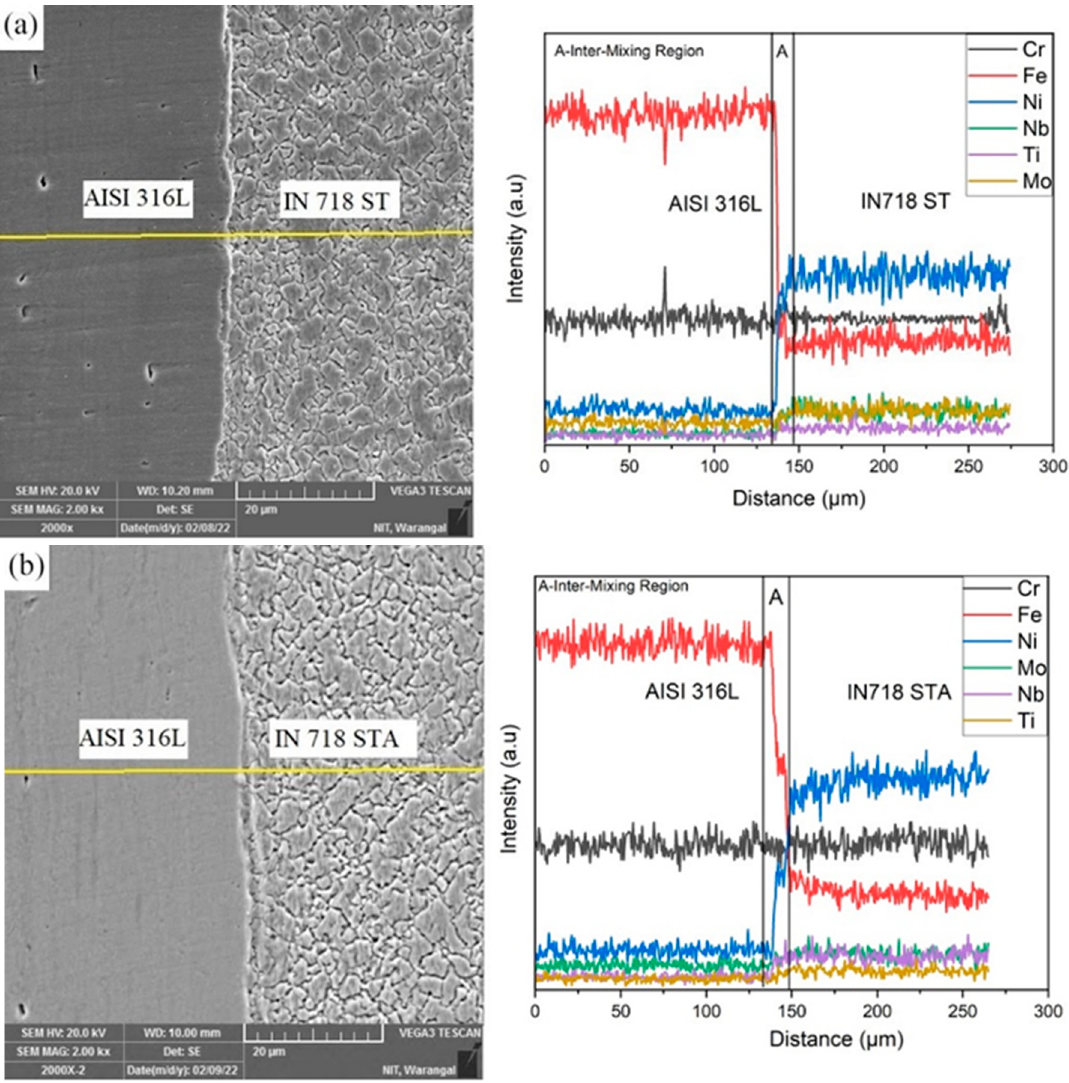
Figure 8. SEM micrograph of dissimilar friction welds ( a ) AISI316L-IN718 ST with EDS line scan and ( b ) AISI316L-IN718 STA with EDS line scan.